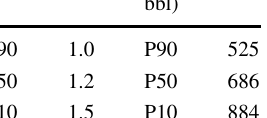
Table 4 Probabilistic result for the yield cutoff of 100 mg HC/g rock, considering the sum of subunits L1, L3, L5, L6 and L7